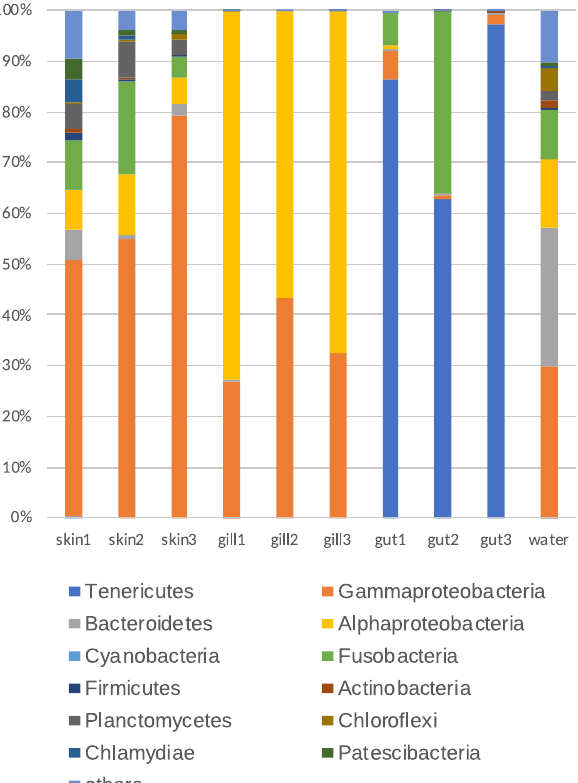
Figure 5. Relative abundance of phyla at sampling sites, and in individual fish, and rearing